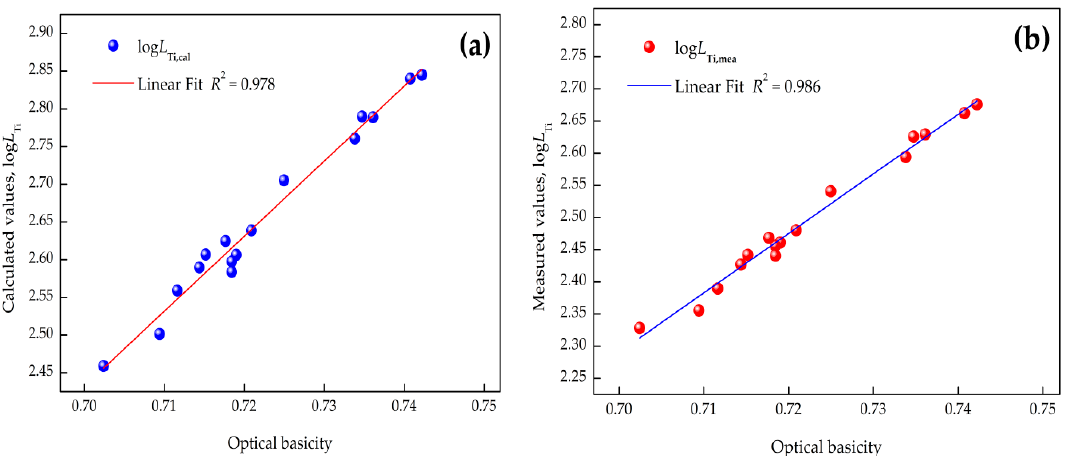
Figure 4. Correlation between complex basicity and titanium distribution ratio: ( a ) calculated by IMCT; ( b ) industrial measurements.